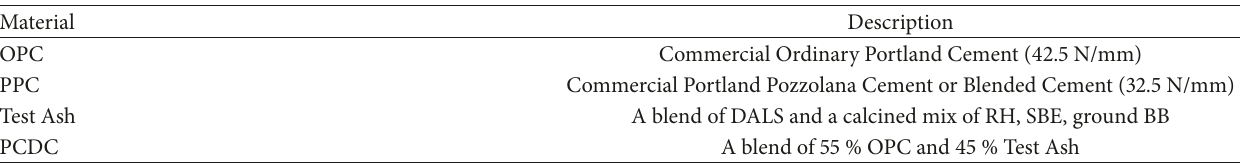
Table 2: Compositions of various materials.